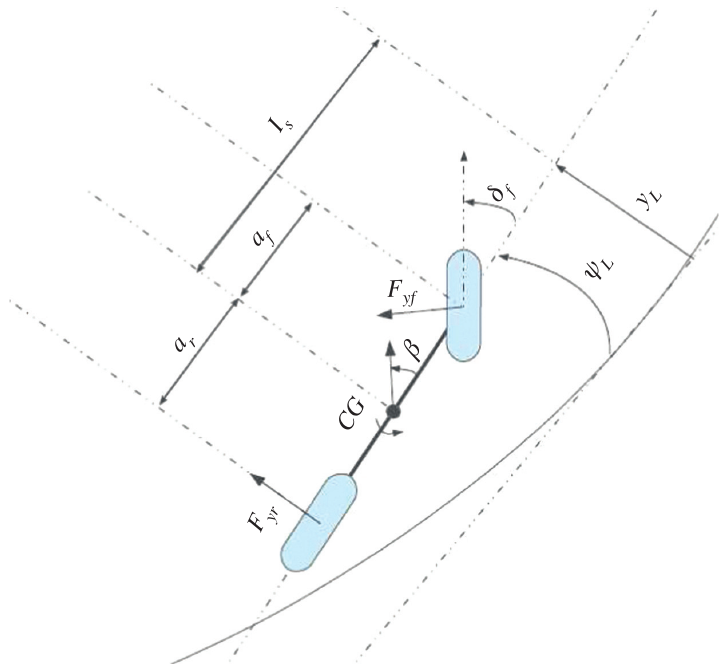
Figure 1. Lateral Vehicle Dynamics and